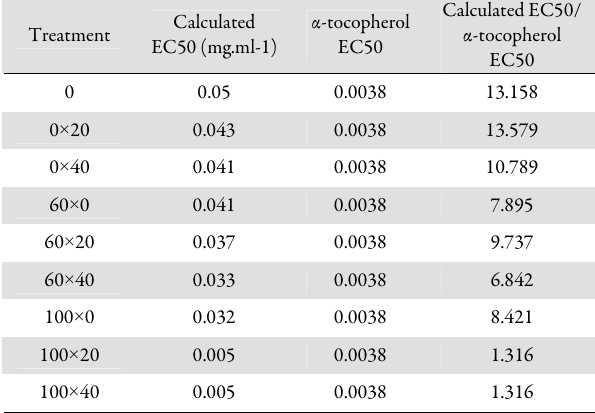
Tab. 2. Calculated EC 50 and its comparison with α -tocopherol EC 50 as positive